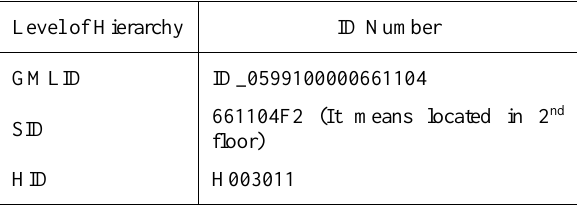
Table 4. Example of ID in each level of hierarchy